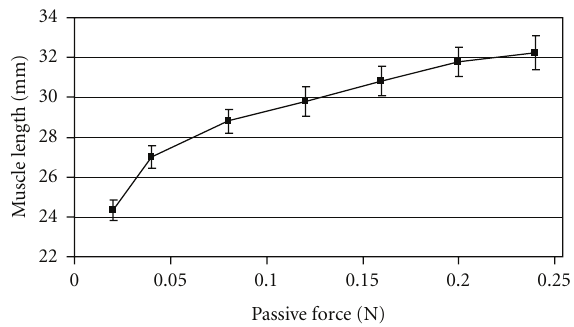
Figure 4: Length of the SM muscle as a function of the passive tension.